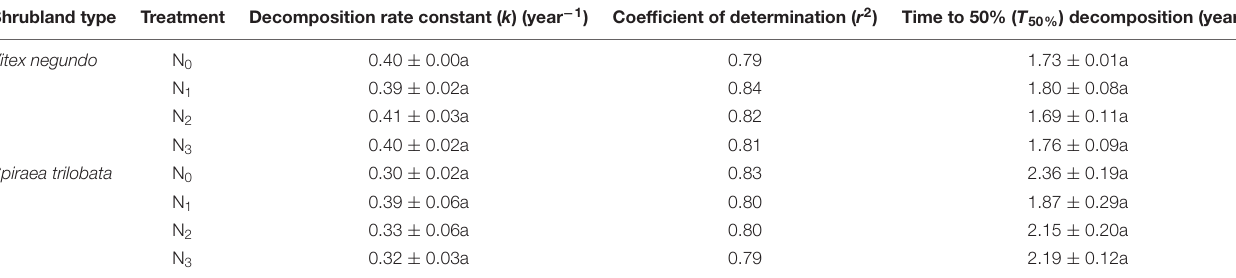
Values are means with 1 ± SE; n = 3. The same lowercase letters in the same row indicate a non-significant difference between different treatments at the 0.95 confidence level. r 2 : Coefficient of determination of negative exponential decomposition equations of litter decomposition. N 0 , control; N 1 , low N; N 2 , moderate N; and N 3 , high N.